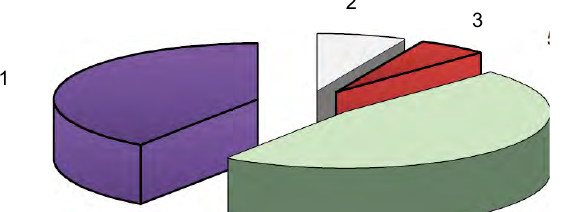
Fig.1. Self-feeling of students at swimming trainings (%) (as per data of V.V. Skirene and E.R. Skirius,